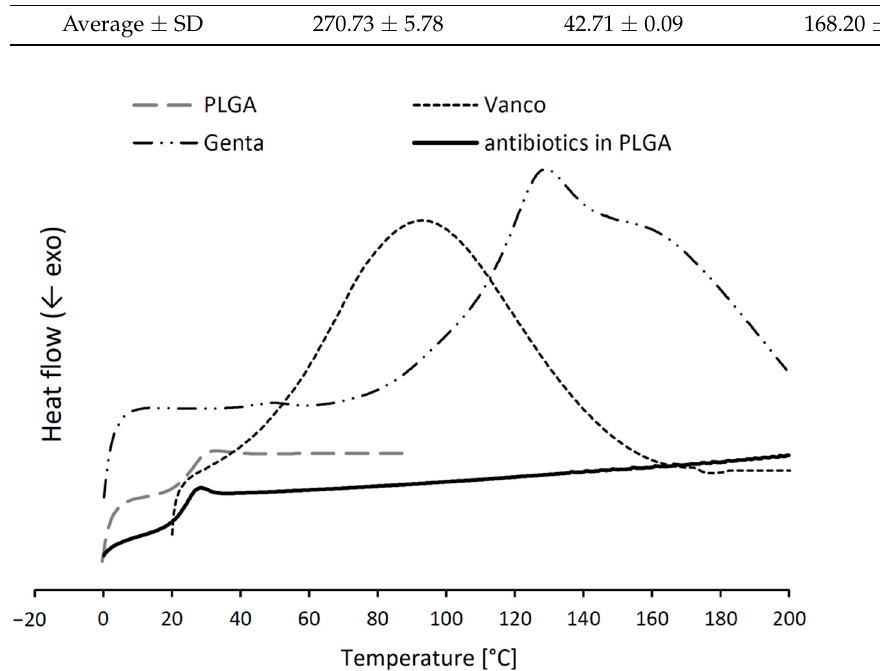
Figure 3. DSC thermograms of the pure PLGA polymer, the pure antibiotic powders, and the anti- biotics loaded in a PLGA solid